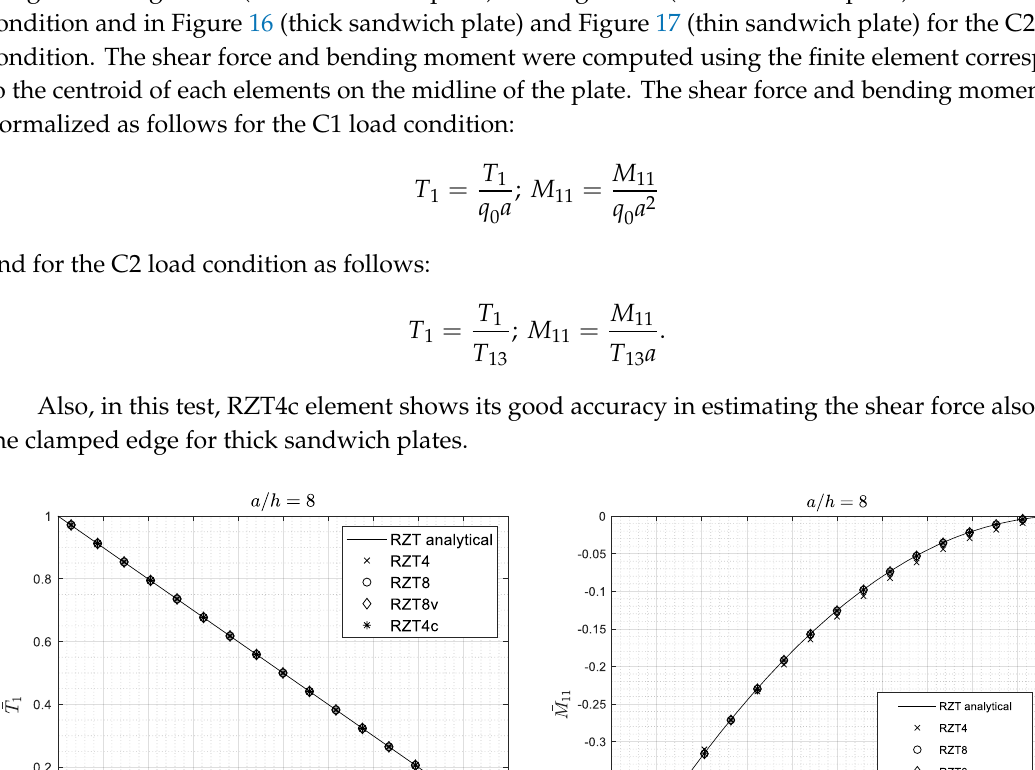
Figure 16. Cantilever thick sandwich (S) square plate under uniform edge transverse pressure (C2). Transverse shear force and bending moment distribution.